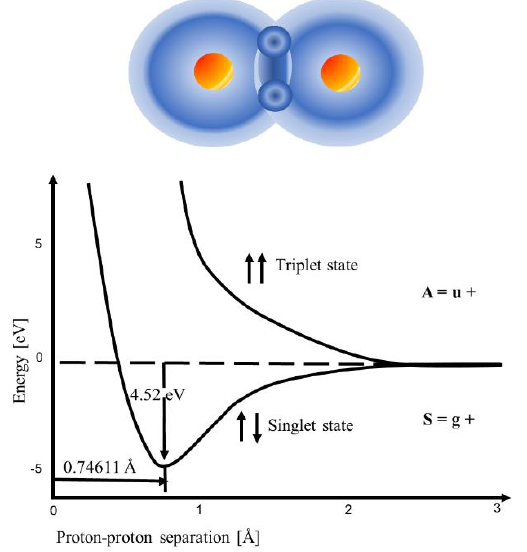
Fig. 1. Molecular hydrogen electron symmetries. Above: the fundamental electron cloud; under: the energies of the first two molecular electron states in function of the proton-proton